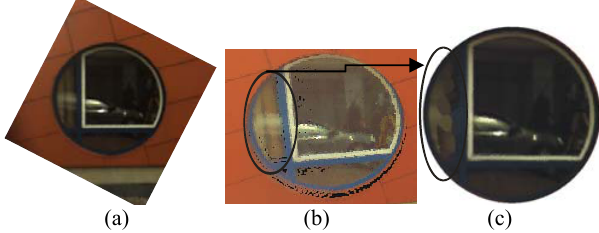
Figure 8. Window from the front façade of the building (a) The image taken with the camera integrated in the scanner system (b) Textured point cloud (c) The surface of the window textured in AutoCad by using the presented algorithm